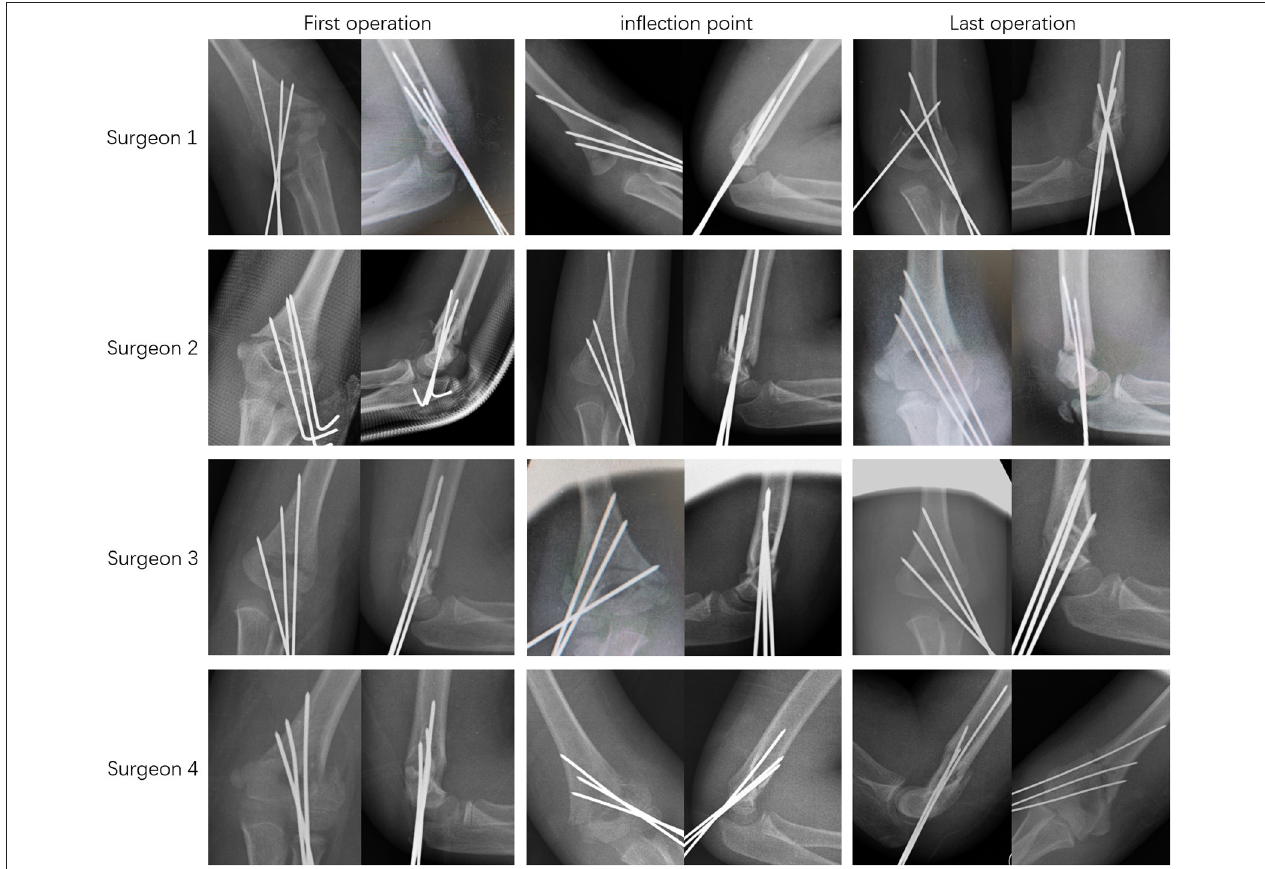
FIGURE 3 | Progress in surgical skills of the four surgeons: Both the fracture reduction and K-wire arrangement of the four surgeons tend to be perfect with the accumulation of surgical